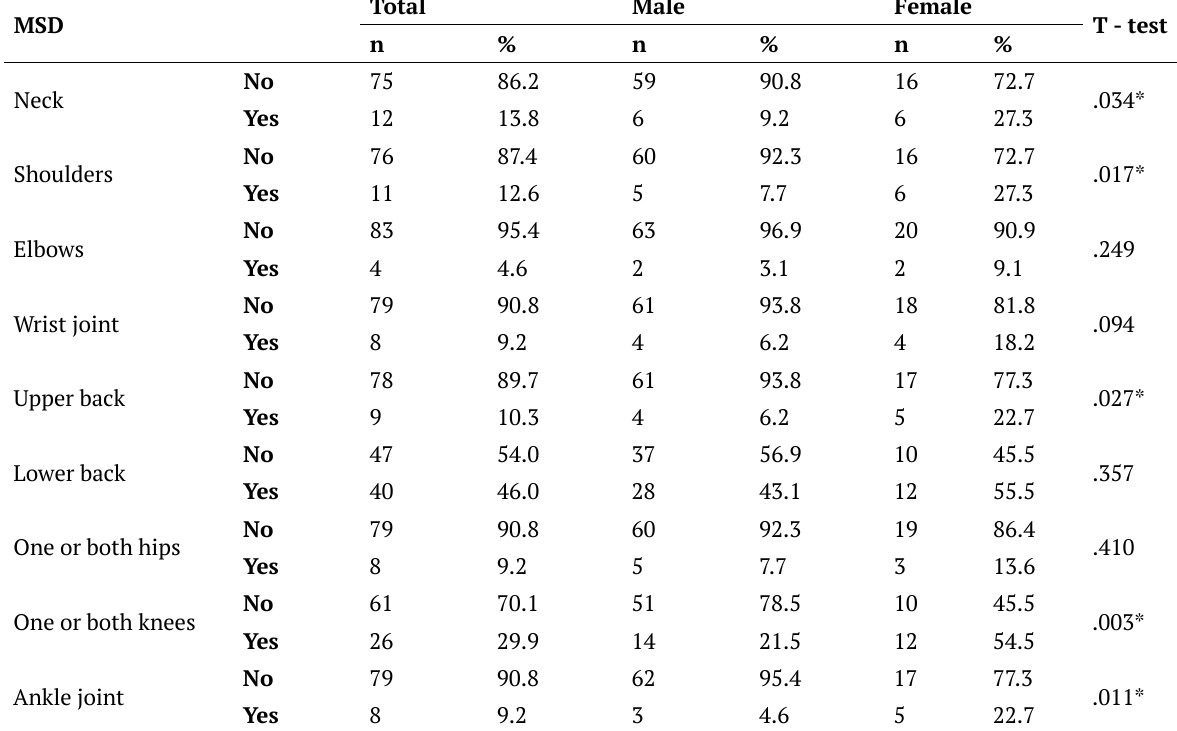
Figure 1. Percentage difference between MSD among male and female ski instructors. “*” Indicates a statistically significant Table 2. Musculoskeletal disorders among ski instructors